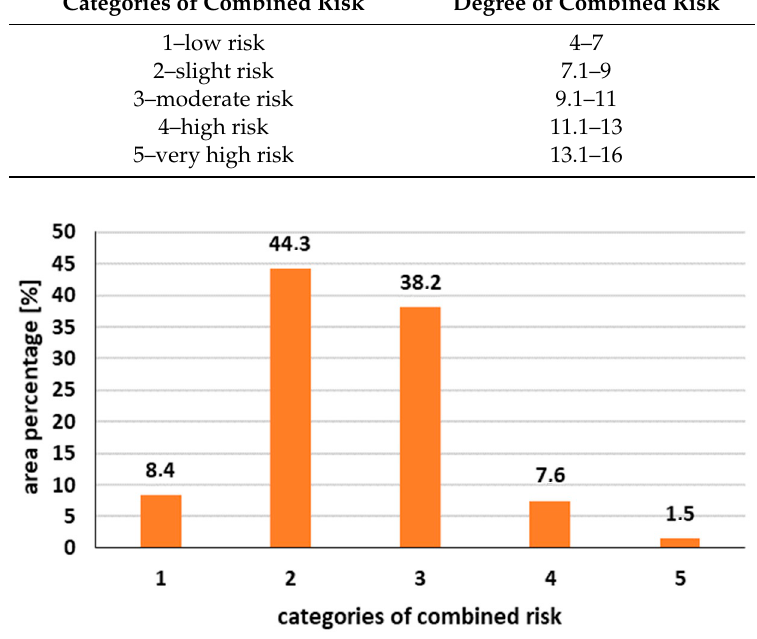
Figure 8. Categories of combined risk. Table 10. Characterization of categories of combined risk in terms of their degree of combined risk (based on Table 9).